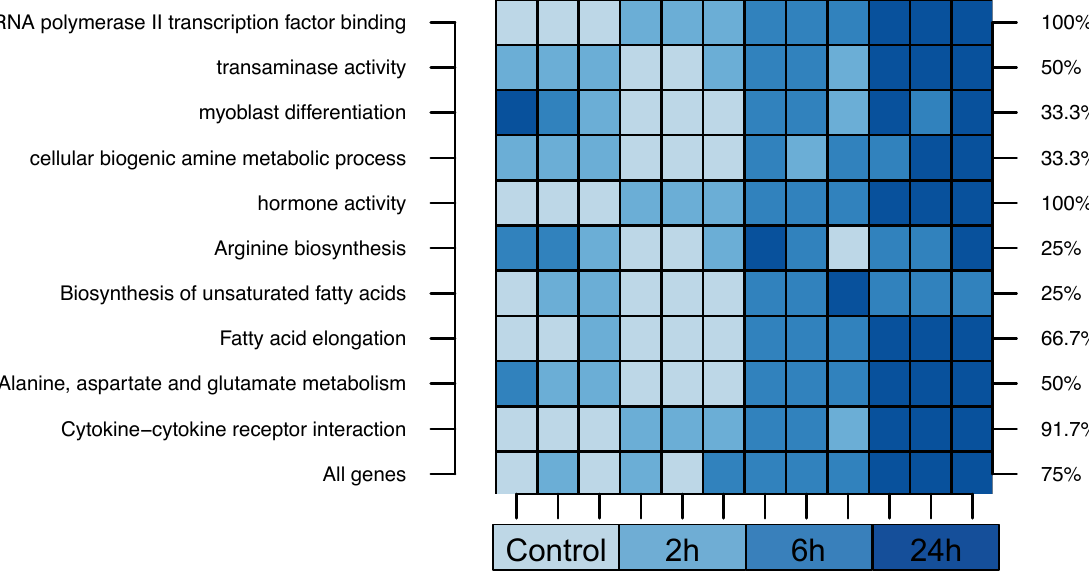
Figure 3. Leave one out cross-validation on rat data using the terms selected in the zebrafish experiments. Additionally, an experiment based on the whole gene expression profiles is shown. Each row indicates a separate experiment. The cell color denotes the predicted stretch time of a sample. The axis on the right gives the overall accuracies (%) of the